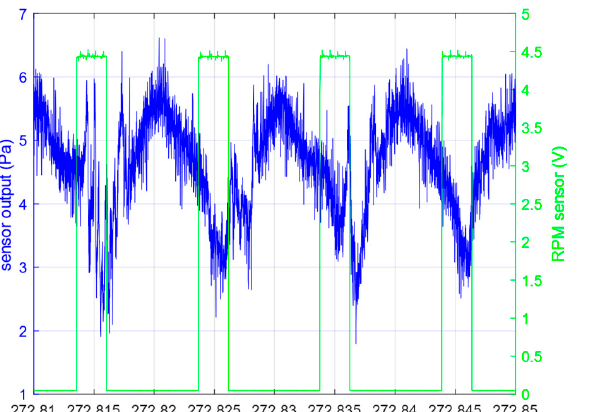
Figure 3. Structure of the measurement system (in ‐ text markings) [16]. The differential pressure (difference between the total pressure at the particular point of the flow and the reference pressure in the steady zone) is converted to a small differential voltage by transducer B. This voltage is amplified by instrumental amplifier D and recorded. During the experiment, the data acquisition system (DAQ) board controlled by a personal computer (PC) application prepared for this experiment collects the voltage samples from the instrumental amplifier and also from the detector used for RPM measurement. The samples of these two signals are presented in Figure 4. The pressure pulses and detector pulses are time ‐ shifted due to the different angular location beyond the propeller.